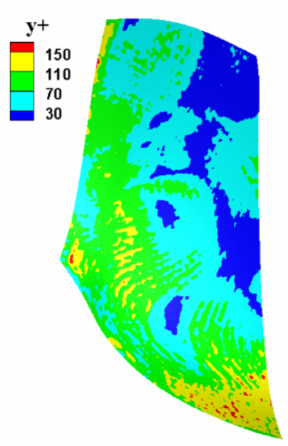
Figure 3. Blade’s y plus for Francis turbine.